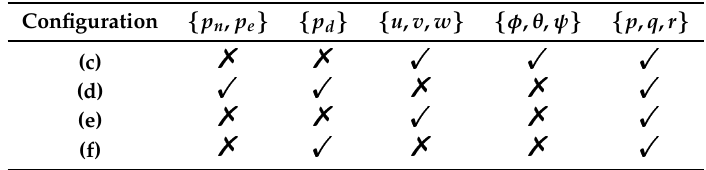
Table 2. Sets of measurements from which the full rank matrix condition ( rank ( OOO ) = dim ( x ) ) is not accomplished, but from which the parameters ( J x , J y , J z , b , k ) can be